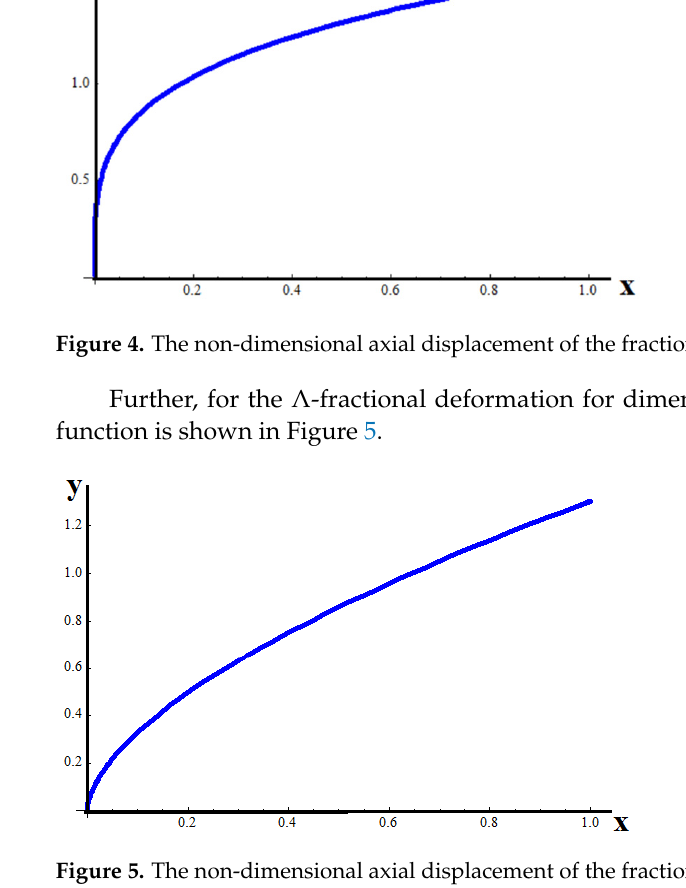
Figure 5. The non-dimensional axial displacement of the fractional bar for γ = 0.8.